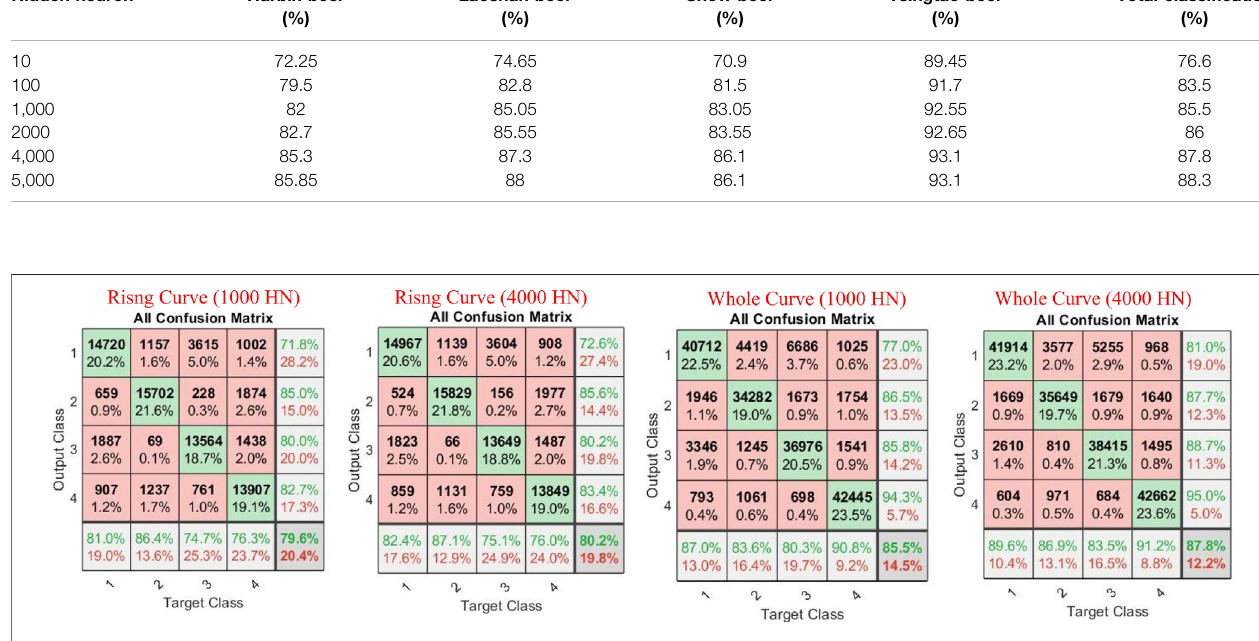
TABLE 3 | Comparison of classi fi cation accuracy with change in number of hidden neurons. Hidden neuron